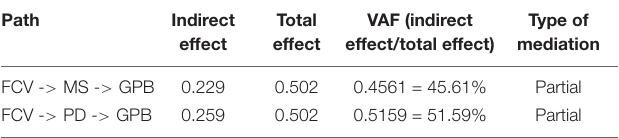
TABLE 7 | Mediation analysis.